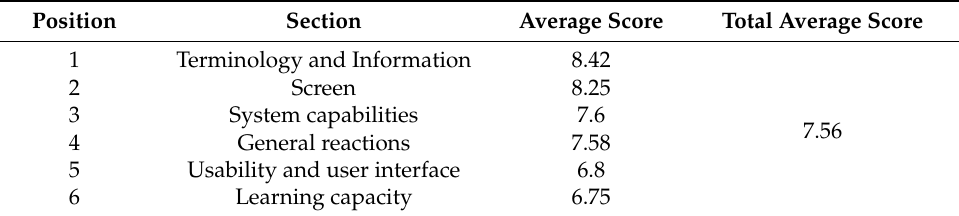
Table 6. Results of Instrument 2, nutritionist